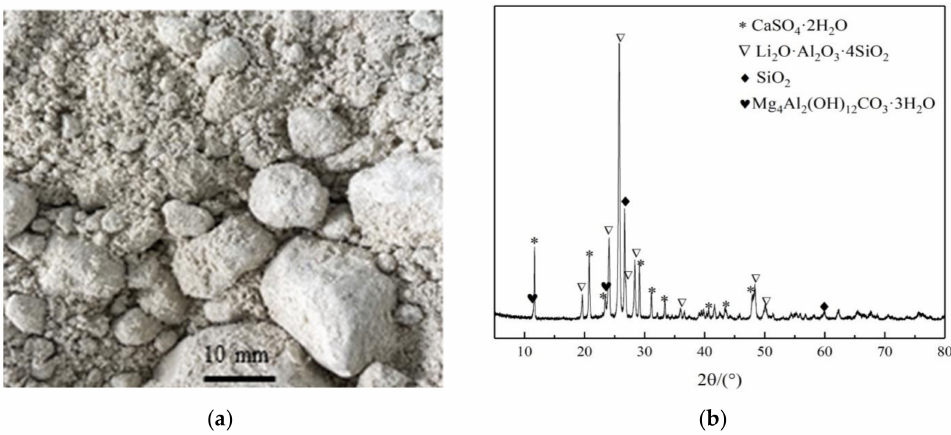
Figure 1. The appearance morphology ( a ) and XRD diffraction pattern ( b ) of the lithium slag. Table 1. Chemical composition of the lithium